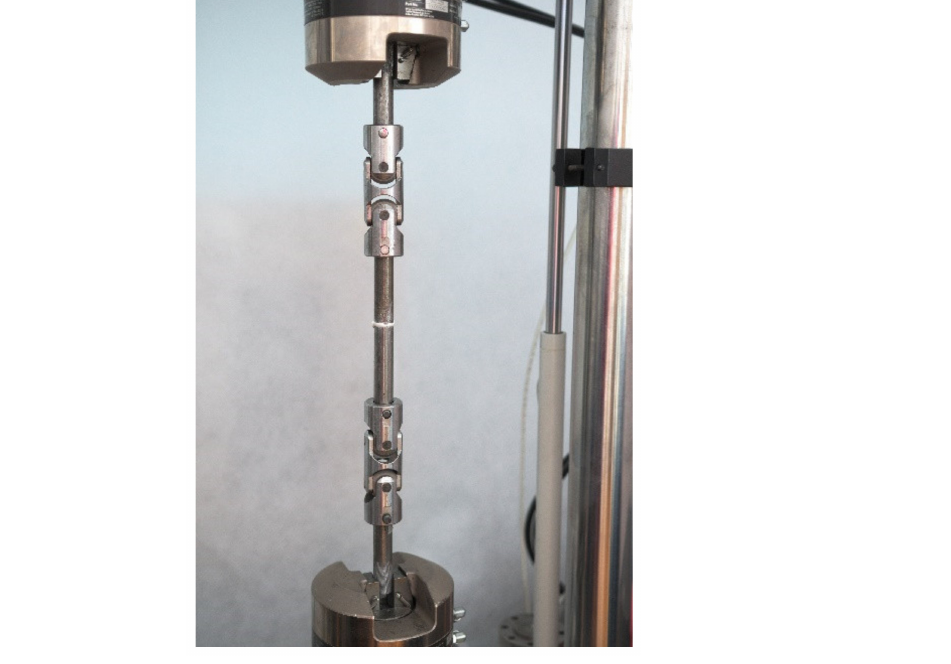
Figure 4. Fixtures with clamps (double-Cardan universal joint). Table 2. Failure patterns: (a) CF—cohesion failure, (b) AF + CF—mixed, (c) ACFP—adhesion and cohesion failure with peel, and (d) AF—adhesion